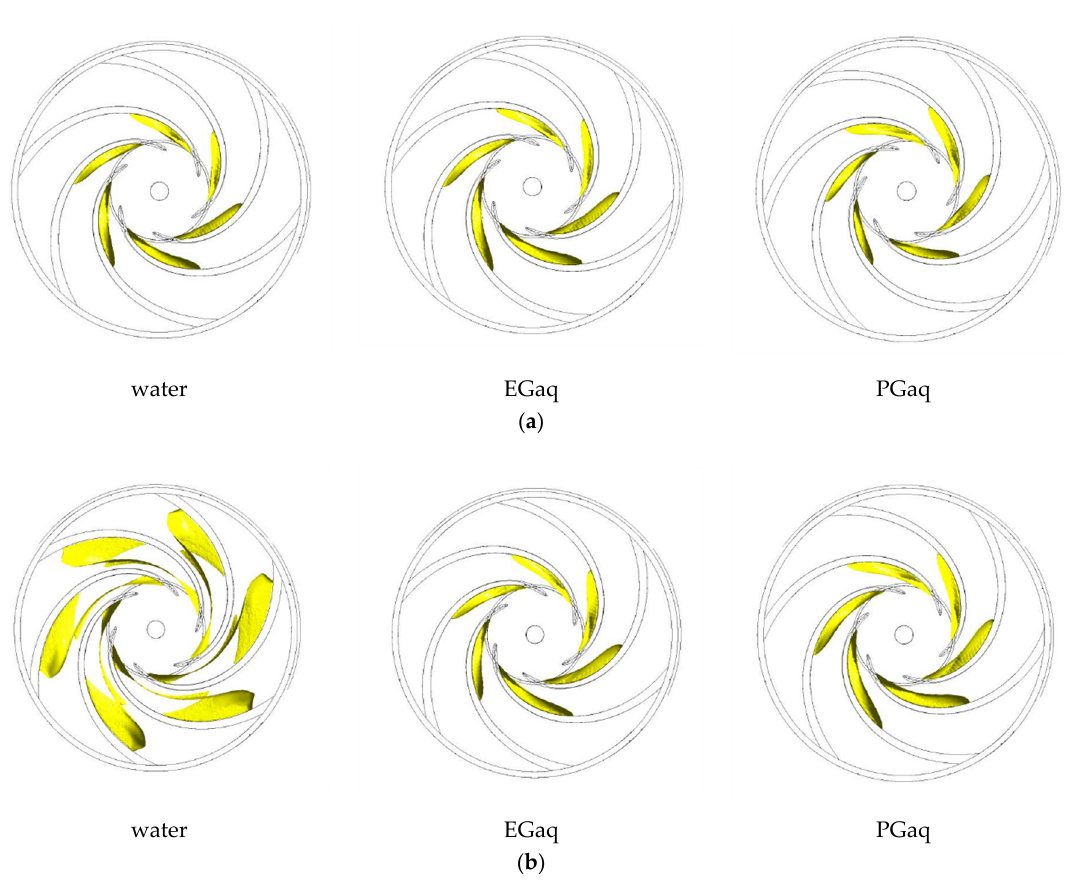
Figure 18. Iso-surface of cavitation distribution in the impeller of cylindrical blades. ( a ) 20 °C at 0.3 atm; ( b ) 60 °C at 0.3 atm